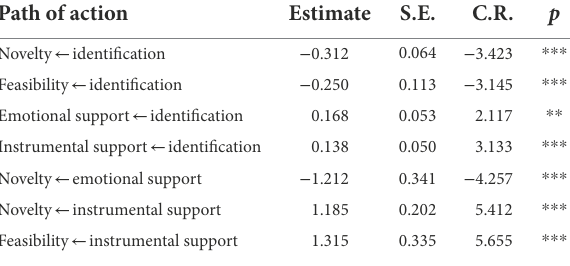
TABLE 7 Test results of the mediating role of family business